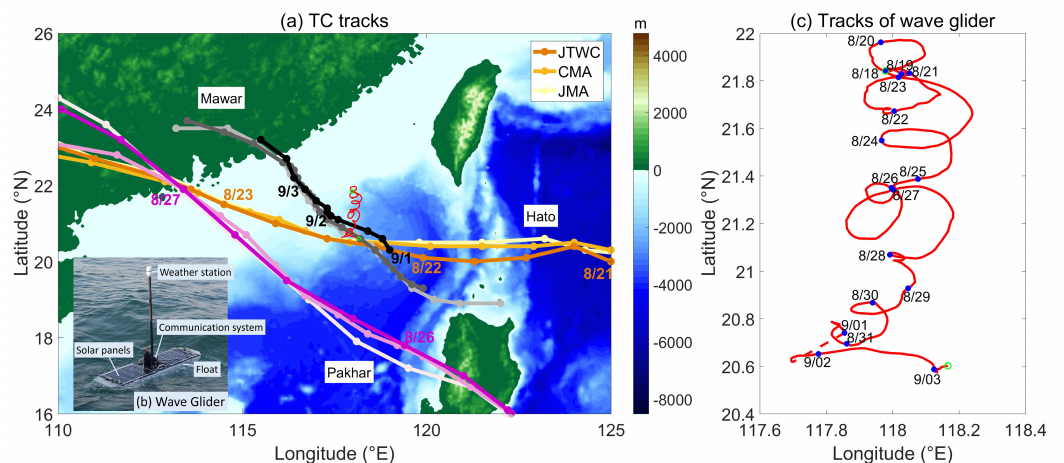
Figure 1. ( a ) Tracks of Hato (yellow colors), Pakhar (pink colors), and Mawar (black colors) from the Joint Typhoon Warning Center (JTWC; dark colors), China Meteorological Administration (CMA; middle colors), and Japan Meteorological Agency (JMA; light colors) data sets, normally showing their position every 6 h (dots). The CMA data set gives the position every 3 h when the tropical cyclone is near the shore. ( b ) Wave glider photo. ( c ) The positions of the wave glider are denoted by red line, with start–end positions marked with green circles (also shown in Figure 1a). The numbers are the observation